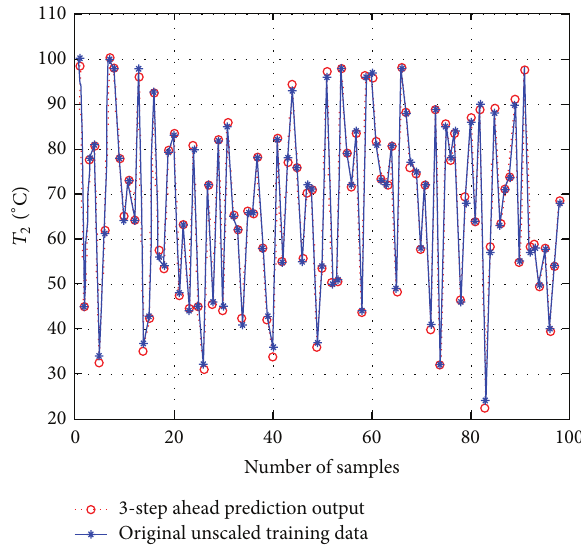
Figure 7: Comparison of the unscaled trained data (blue solid line) with 3-step ahead output predictions by the trained NN (red dotted line) for ̂𝑦(𝑇 2 )